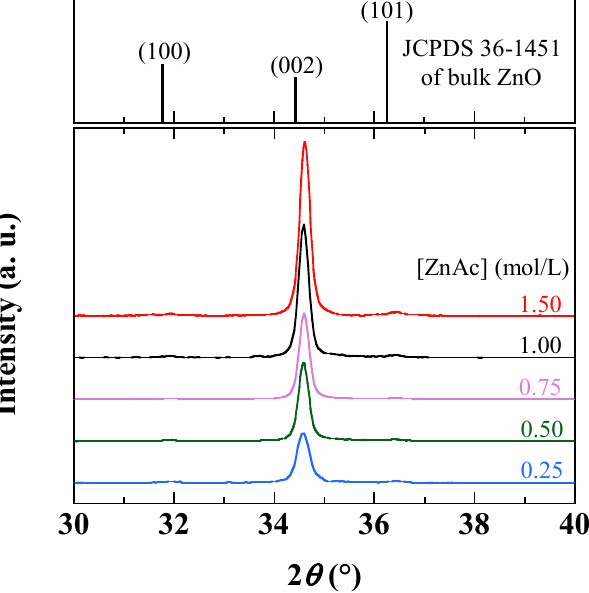
Figure 5. X-ray diffractograms of sol-gel spin-coated ZnO samples obtained with various ZnAc contents. The JCPDS 36-1451 of bulk ZnO within the same 2 θ range is also displayed.